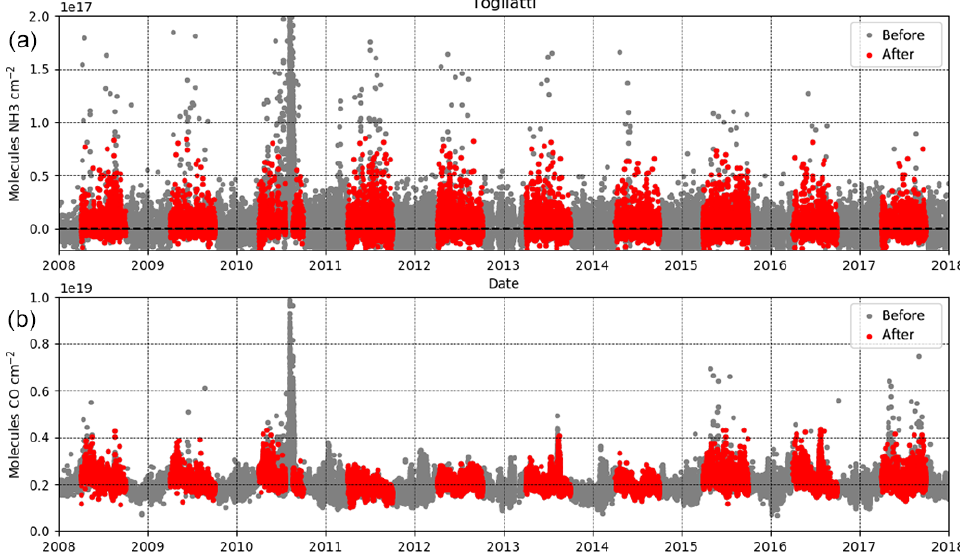
Figure 2. Data selection example for Togliatti, Russia. Panel (a) shows the IASI-A NH 3 dataset “before” observations are filtered out (grey) and the observations kept “after” (red) the selection. Panel (b) shows the corresponding IASI-A CO